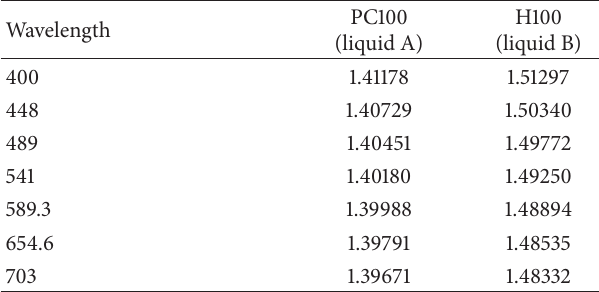
Table 2: The refractive index of liquid lens